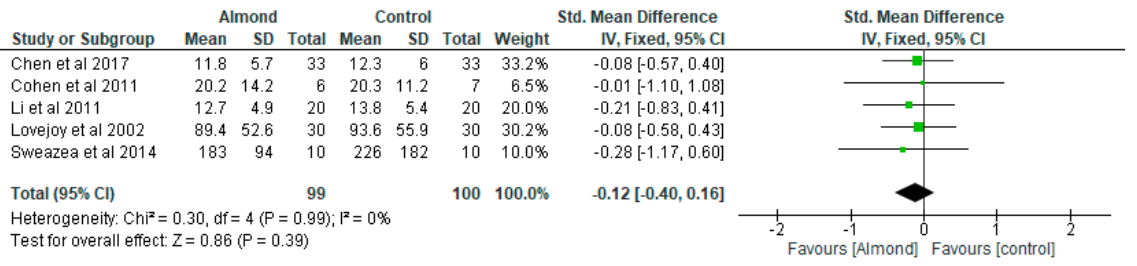
Figure 8. The effect of almond on fasting insulin (standardised mean difference).